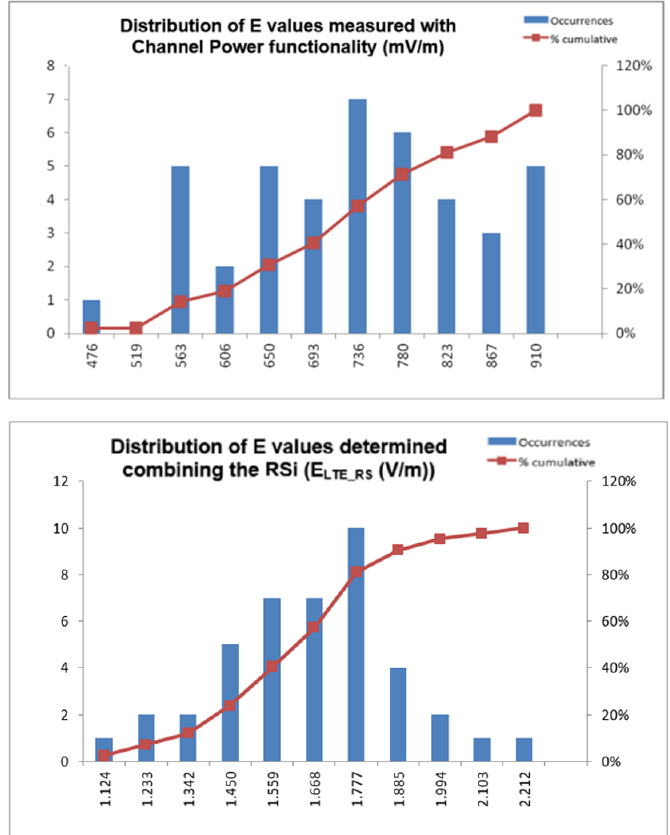
Figure 2. E value distributions measured in the RSi and Channel Power (CP) modalities. The distributions obtained had a variation coefficient of 16% and 14%.